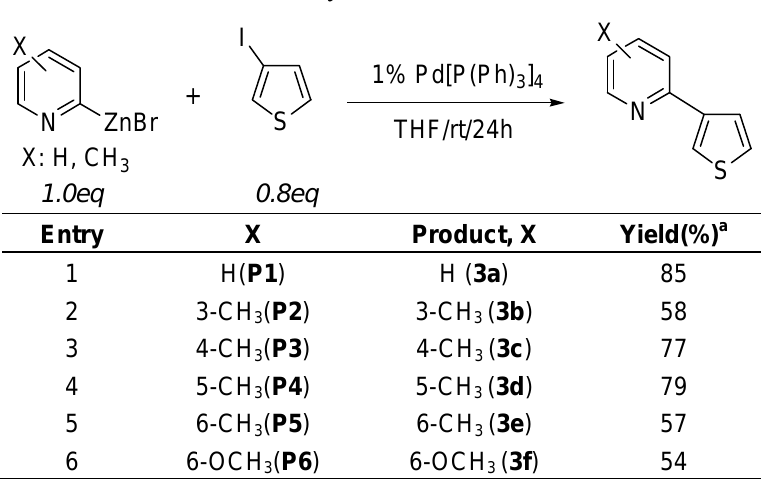
Table 3. Study of substitutent